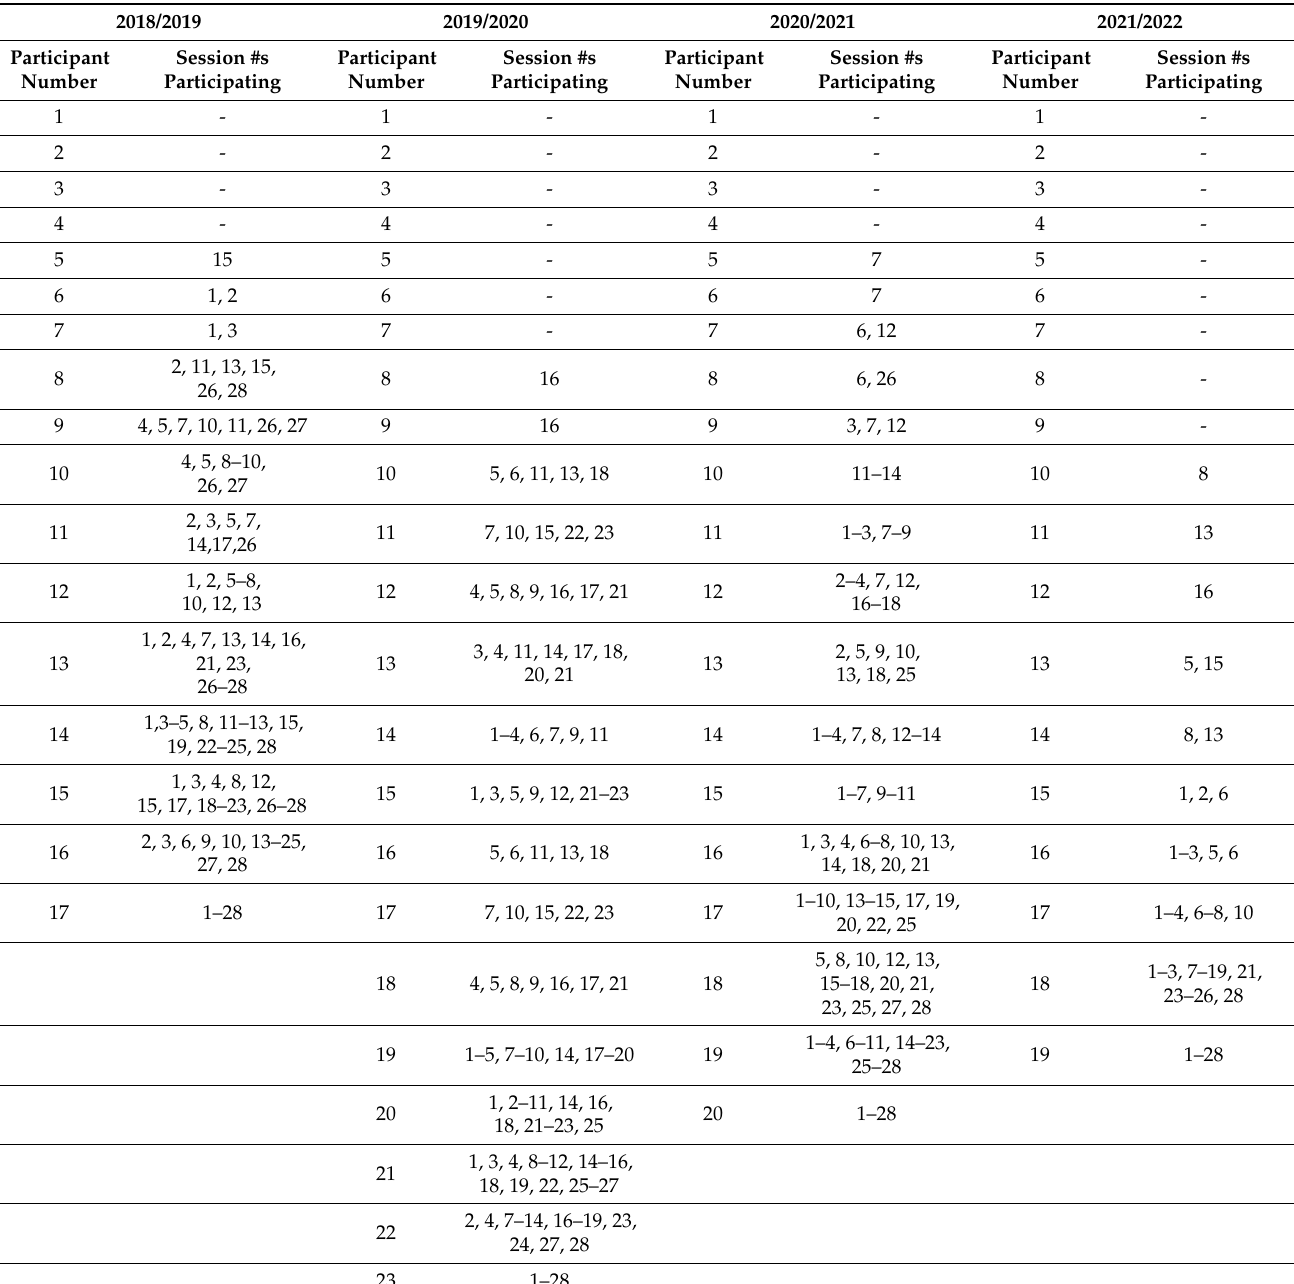
Table 1. Total Question-Asking by all Participants in Each of the Most Recent Four Years (2018/2019, 2019/2020, 2020/2021, 2021/2022) of the HeNReG Over the Twenty-Eight Sessions by the Session Numbers Each Participant Asked Questions Ordered from Those Participants Who Question-Asked the Fewest Sessions to Those Who Question-Asked the Greatest Number of